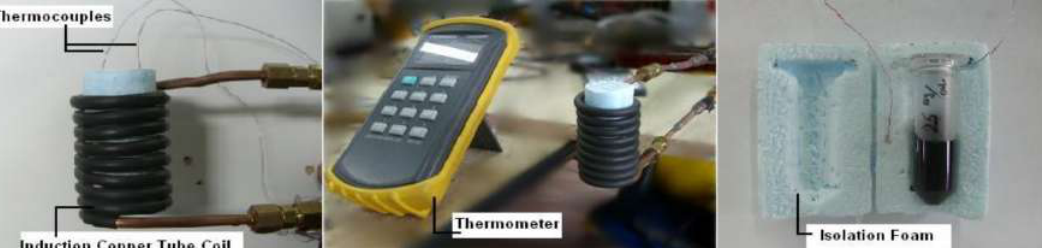
Fig 2 . Experimental setup where MNPs in different concentrations were placed in an isolation foam that was fitted for the inside of the cylindrical coil attached to the hyperthermia machine. Thermocouple probes measured the temperature of the MNPs and the isolation